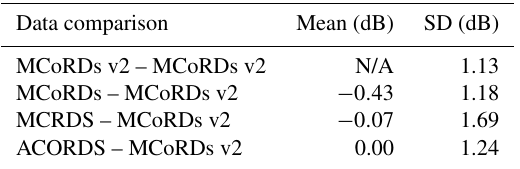
Table A1. Crossover statistics for σ [ R ] for the different radar instru- ment classes in Fig.